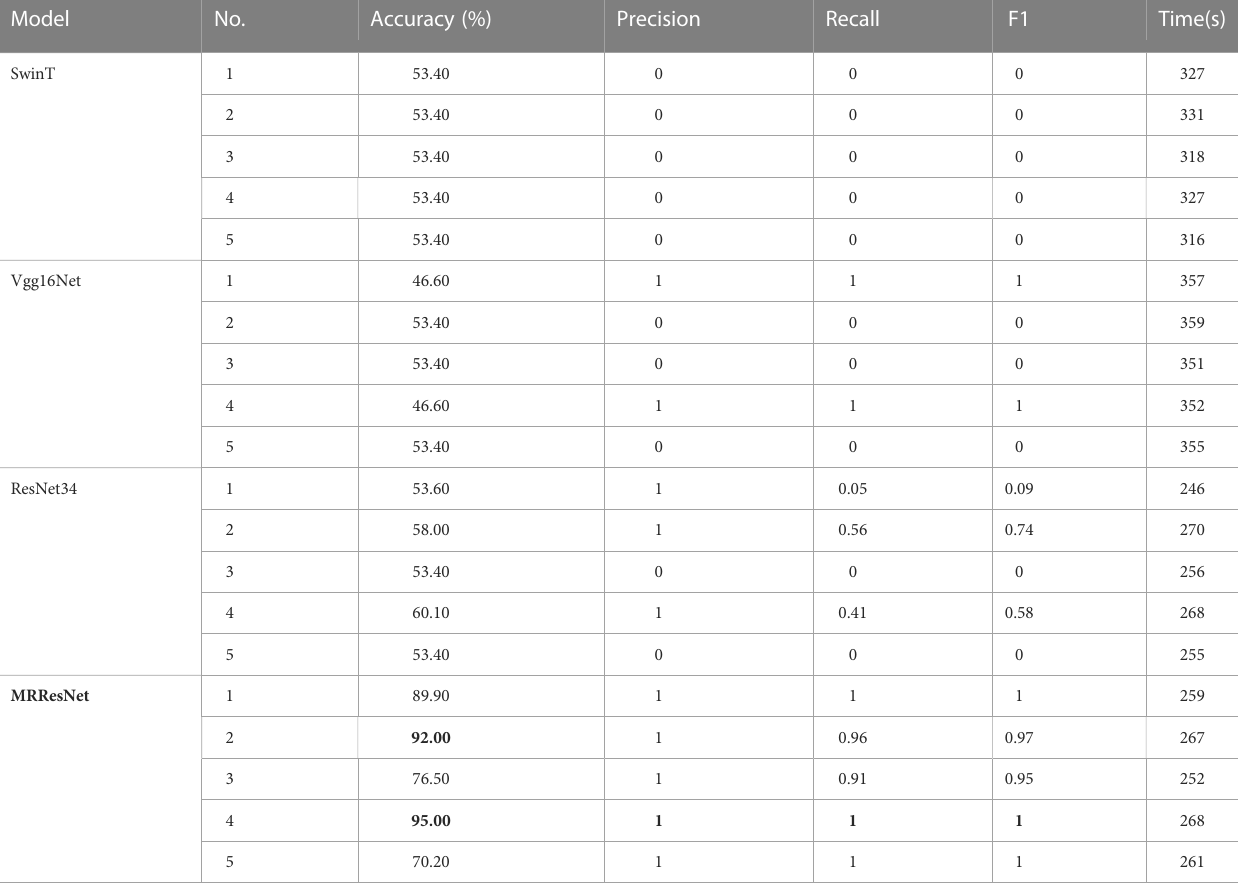
TABLE 4 Classi fi cation results of the MRI images of healthy versus Vd-infested cotton root systems. Model No.